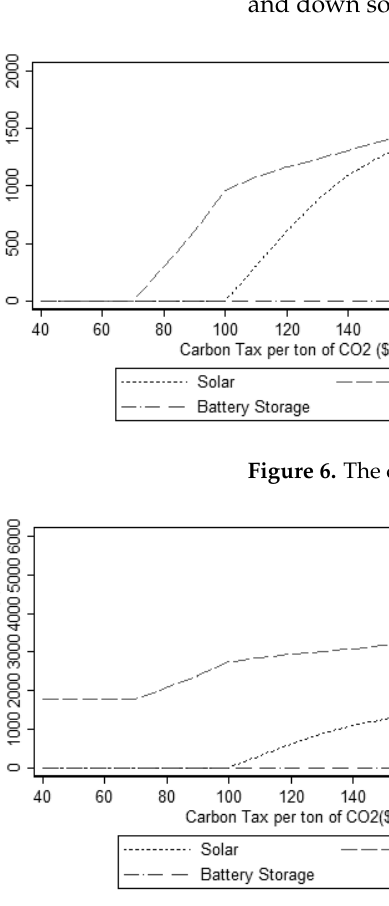
Figure 7. The capacities of generators with the increasing carbon tax.